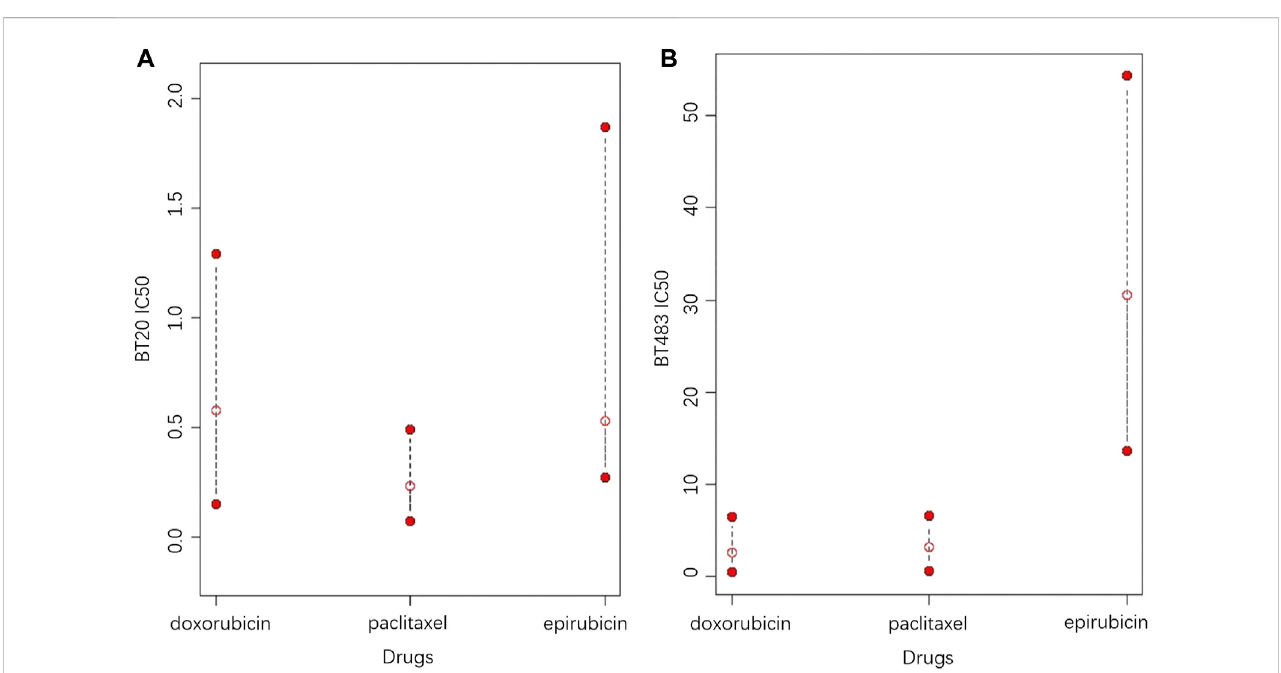
FIGURE 6 The 95% prediction intervals and point predictions of Epirubicin, Doxorubicin and Paclitaxel for cell lines (A) BT20 and (B) BT483 (the open red dots represent the point prediction of drug response, and the two solid red dots represent the upper and lower bounds of the 95% prediction interval).